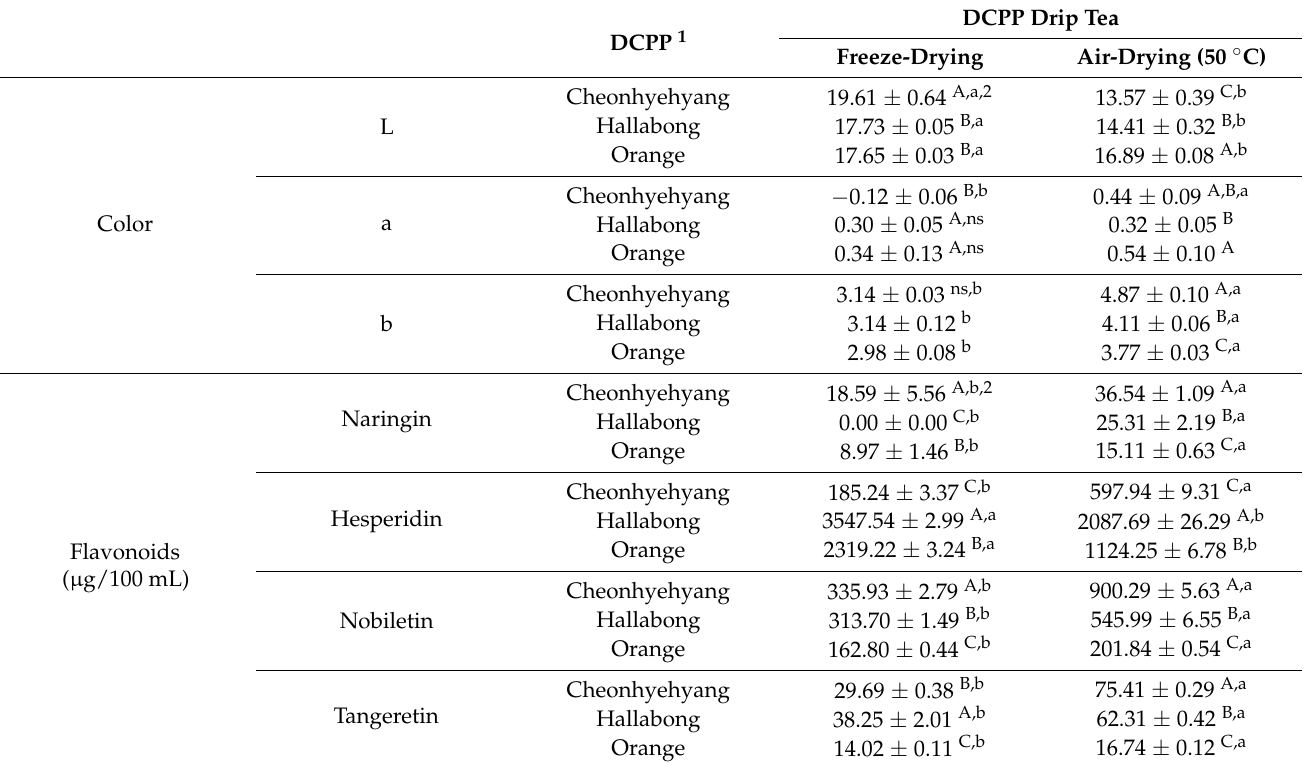
Table 2. Color and flavonoid contents of machine-drip tea prepared from